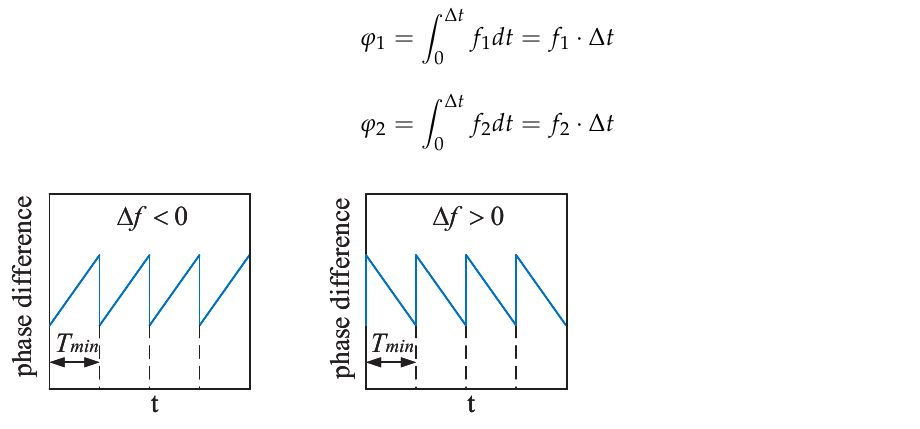
Figure 3. Variation law of phase difference between two signals with a small fixed-frequency difference.